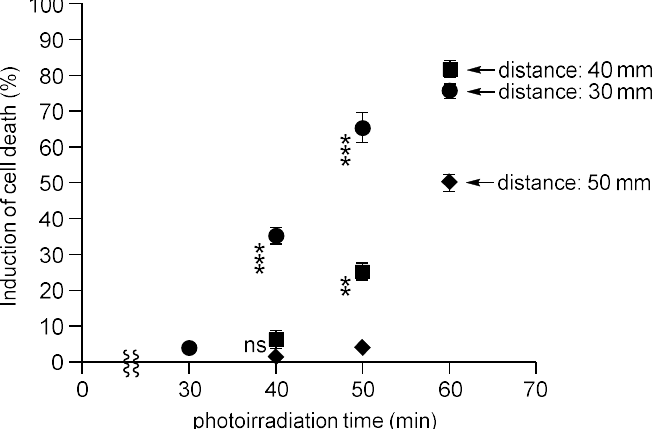
Figure 6. Induction of cell death in HeLa S3 cells monitored by PI staining after photoirradiation at 470 nm through WPT in the presence of 7 (10 µ M) for different photoirradiation times (30–60 min) and at different distances between the PT and PR devices (( • ) 30 mm, ( ■ ) 40 mm, and ( ♦ ) 50 mm). The ratio of dead cells = (number of cells stained with PI/total number of cells) × 100. The statistical analysis is performed at 40 min and 50 min, respectively. ** p < 0.01, *** p < 0.001, ns: not significant.